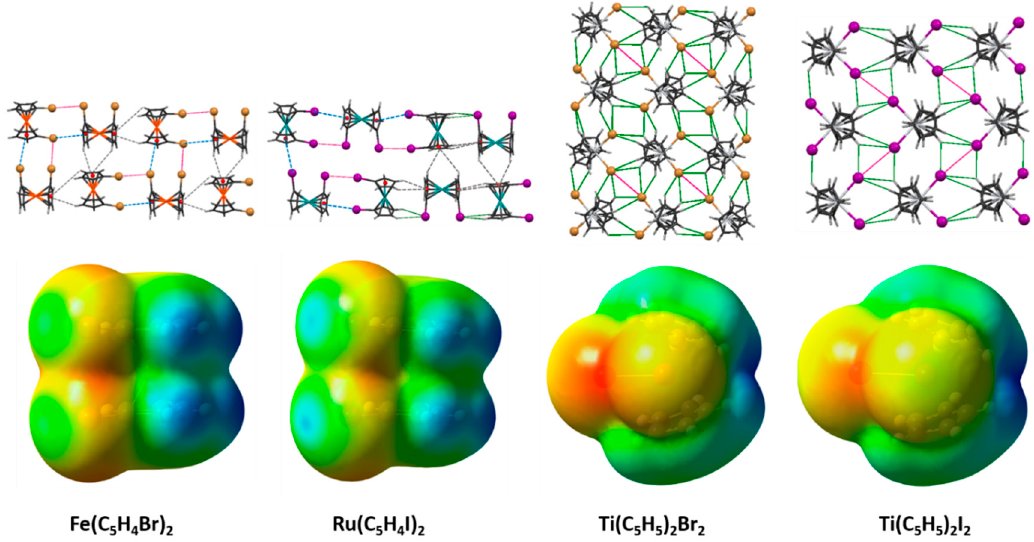
Figure 10. Primary supramolecular arrangements of Fe(C 5 H 4 Br) 2 , Ru(C 5 H 4 I) 2 and Ti(C 5 H 5 )X 2 (X = Br, I) ( top ); electrostatic potential mapped onto an electron density isosurface for the same compounds ( bottom ).